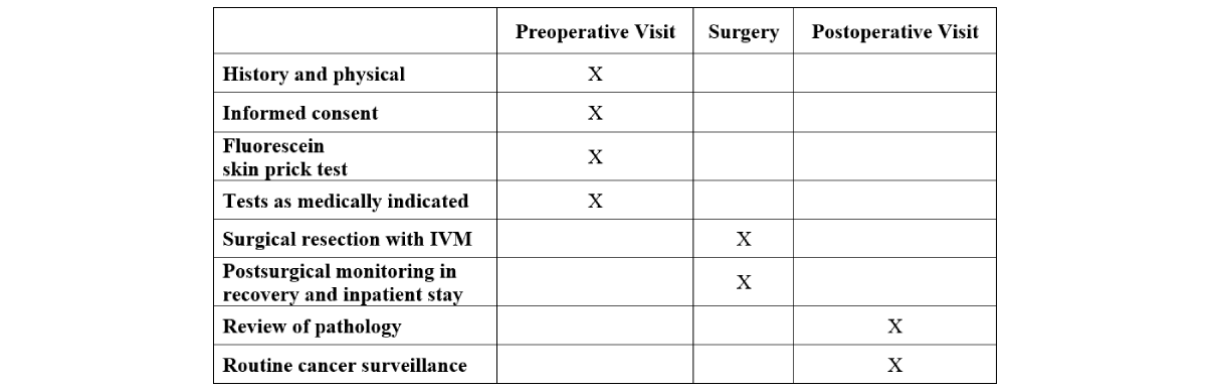
Figure 1. Summary of the evaluations performed during the protocol. IVM: intravital